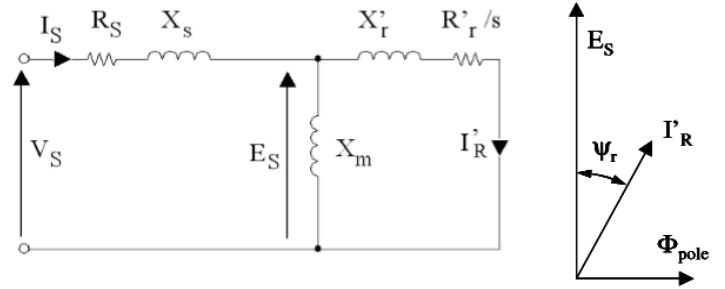
Figure 4. The simplified equivalent circuit model of an induction machine [39].